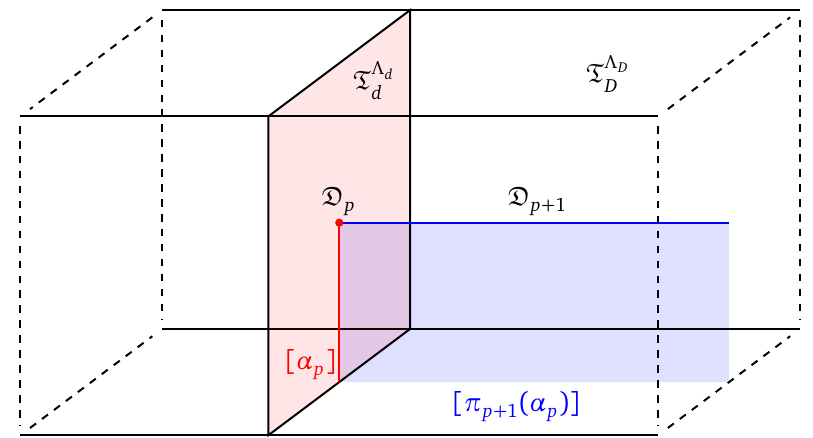
Figure 16: A “non-genuine” sub-defect D the end of a non-genuine defect D figuration occurs when the equivalence class α